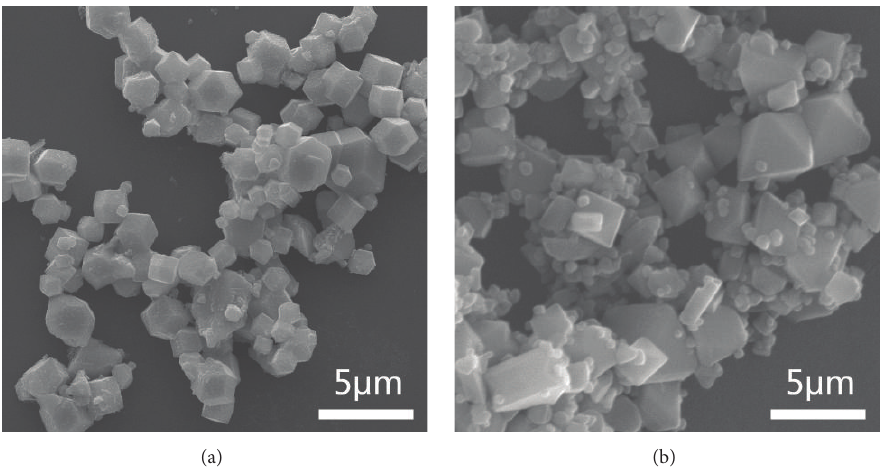
Figure 6: SEM images of samples obtained in the presence of EDTA (a) and in the absence of EDTA (b) at pH = 9.